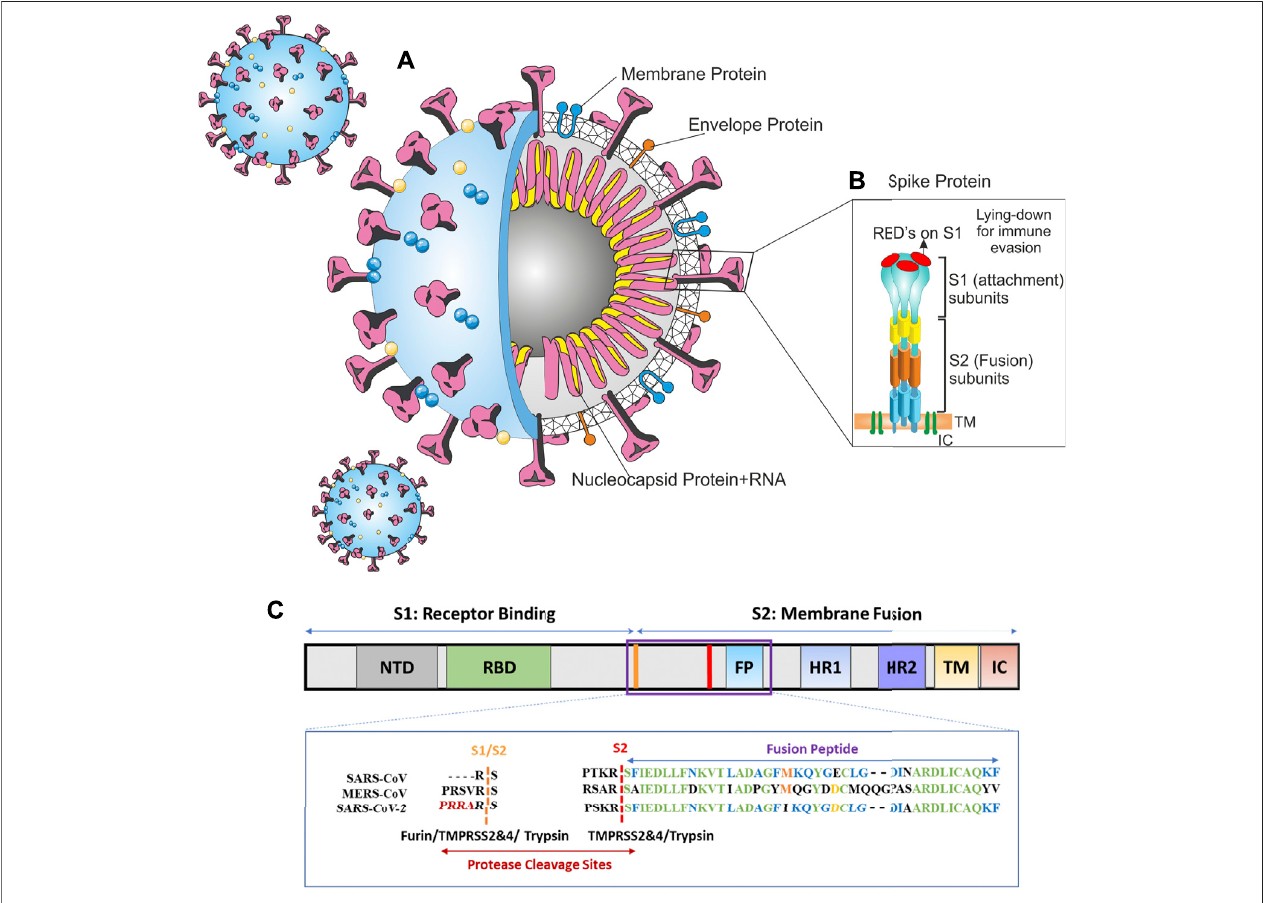
FIGURE 1 | Architecture of SARS-CoV-2 virus (A) SARS-CoV-2 schematic (B) spike protein, (C) alignment of SARS-CoV-2, MERS-CoV, and SARS-CoV sequences inprotease cleavage sites S1/S2 and S2. Afurincleavage motif (RRAR) only exists inthe SARS-CoV-2spike. Trypsin, furin, and TMPRSS2and 4 cancleave theS1/S2sitewithinthereceptorbindingdomain(RBD)ofSproteingeneratingtheoptimalconformationforviralbindingtothehostACE2receptor.Theviralmembrane fusion with the host membrane S2 domain can be cleaved by TMPRSS 2 and 4. Panel C is adapted from Luan et al. (2020).